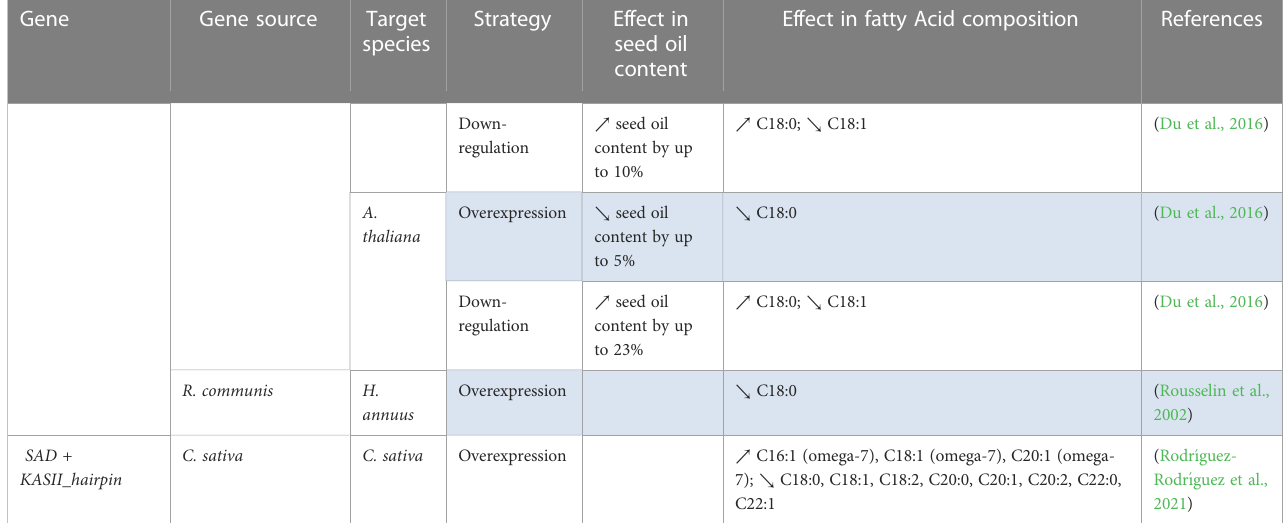
(Table 3). In parallel, speci fi c enzymes in the fi rst committed steps of de novo FAS have also been targeted, such as acetyl-CoA carboxylase (ACCase) (Dong et al., 2002; Cui et al., 2017), and malonyl CoA-ACP malonyltransferase (MCAMT) (Jung et al., 2019) (Table 4). Finally, several studies demonstrated that overexpression of membrane- intrinsic proteins that mediate the export of FAs from plastids, such as FA export 1 ( FAX1 ) (Li et al., 2015b; Tian et al., 2018; Li et al., 2020b; Cai et al., 2021), FAX2 and FAX4 (Li et al., 2015b; Li et al., 2016a; Li et al., 2020b), BILE ACID : SODIUM SYMPORTER FAMILY PROTEIN 2 (BASS2) (Lee et al., 2017), and fatty